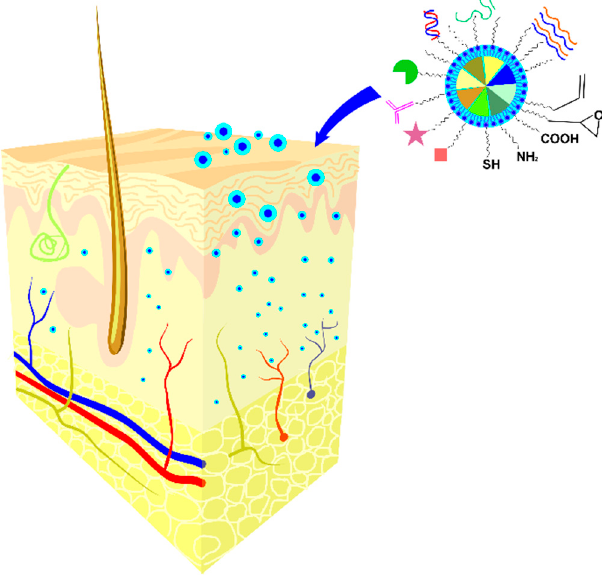
Figure 3. Schematic illustration of nano-scale carrier systems and their interactions with the dermal barrier.